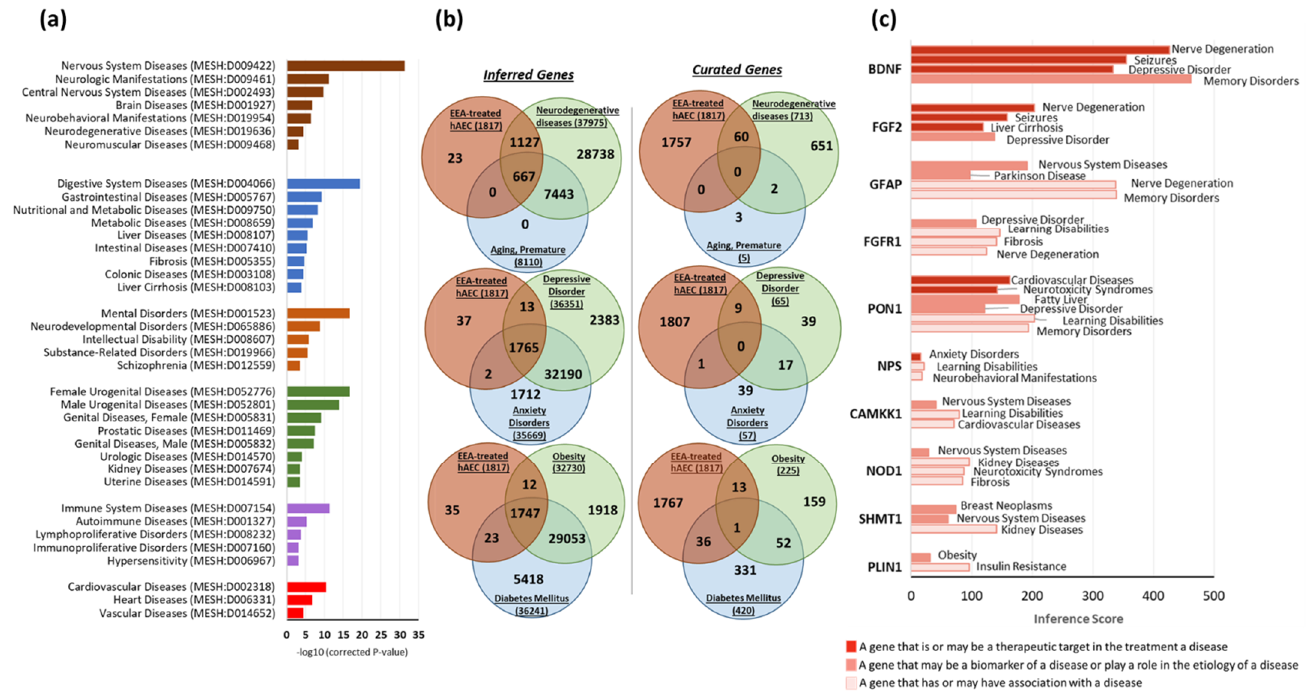
Figure 8. Curated gene-disease association. ( a ) Bar graph showing statistically enriched diseases terms (MESH) by the DEGs using the Set Analyzer tool of the Comparative Toxicogenomics Database (CTD). The significance of enrichment is calculated by the hypergeometric distribution and adjusted for multiple testing using the Bonferroni method. ( b ) Comparison of gene list (in EEA-SQ-treated hAECs) with direct relationships to specific disease terms for both inferred and curated gene-disease associations. MyGeneVenn tool of CTD data base was used to create Venn diagrams. ( c ) Bar graph showing the inference score of selected genes with direct evidence of disease association.